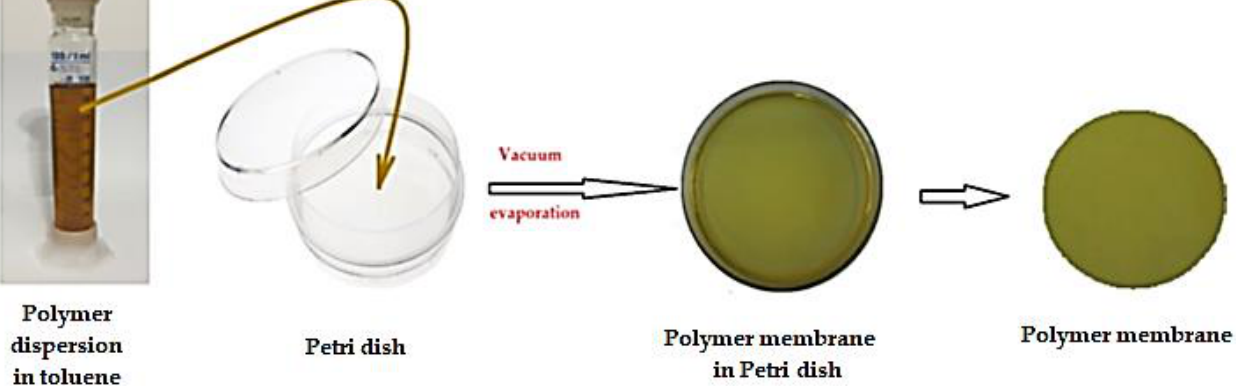
Figure 2. Schematic representation of the procedure for obtaining sEPDM based membranes.